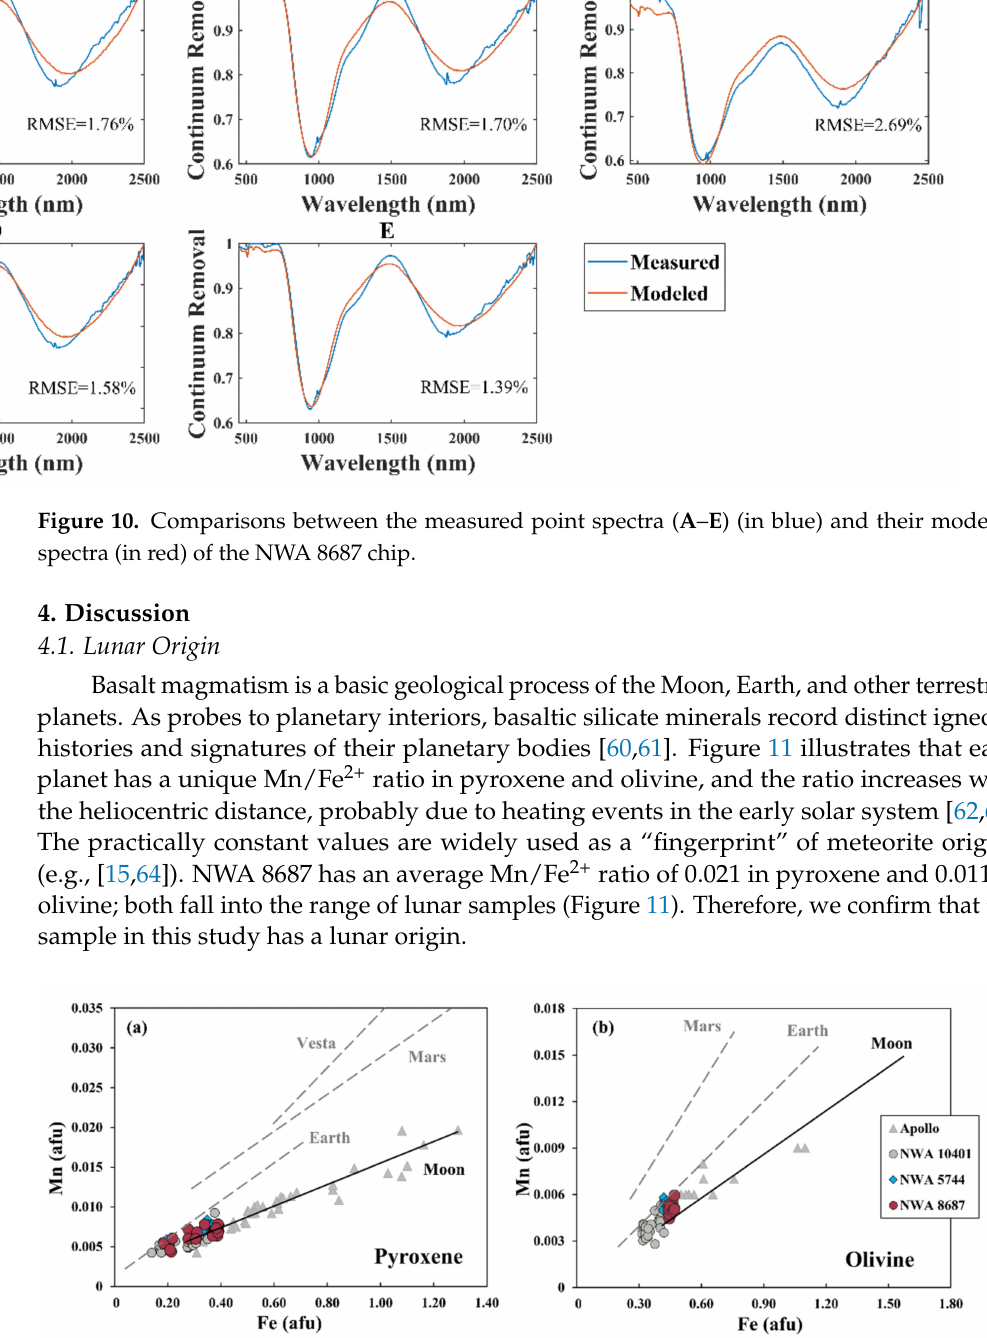
Figure 11. Mn versus Fe 2+ atoms per formula unit (afu) in pyroxene ( a ) and olivine ( b ) of NWA 8687, compared with pairs NWA 5744 [32] and NWA 10401 [15]. Apollo data and best-fit trend lines are from Ref. [60] (pyroxene) and Ref. [61]